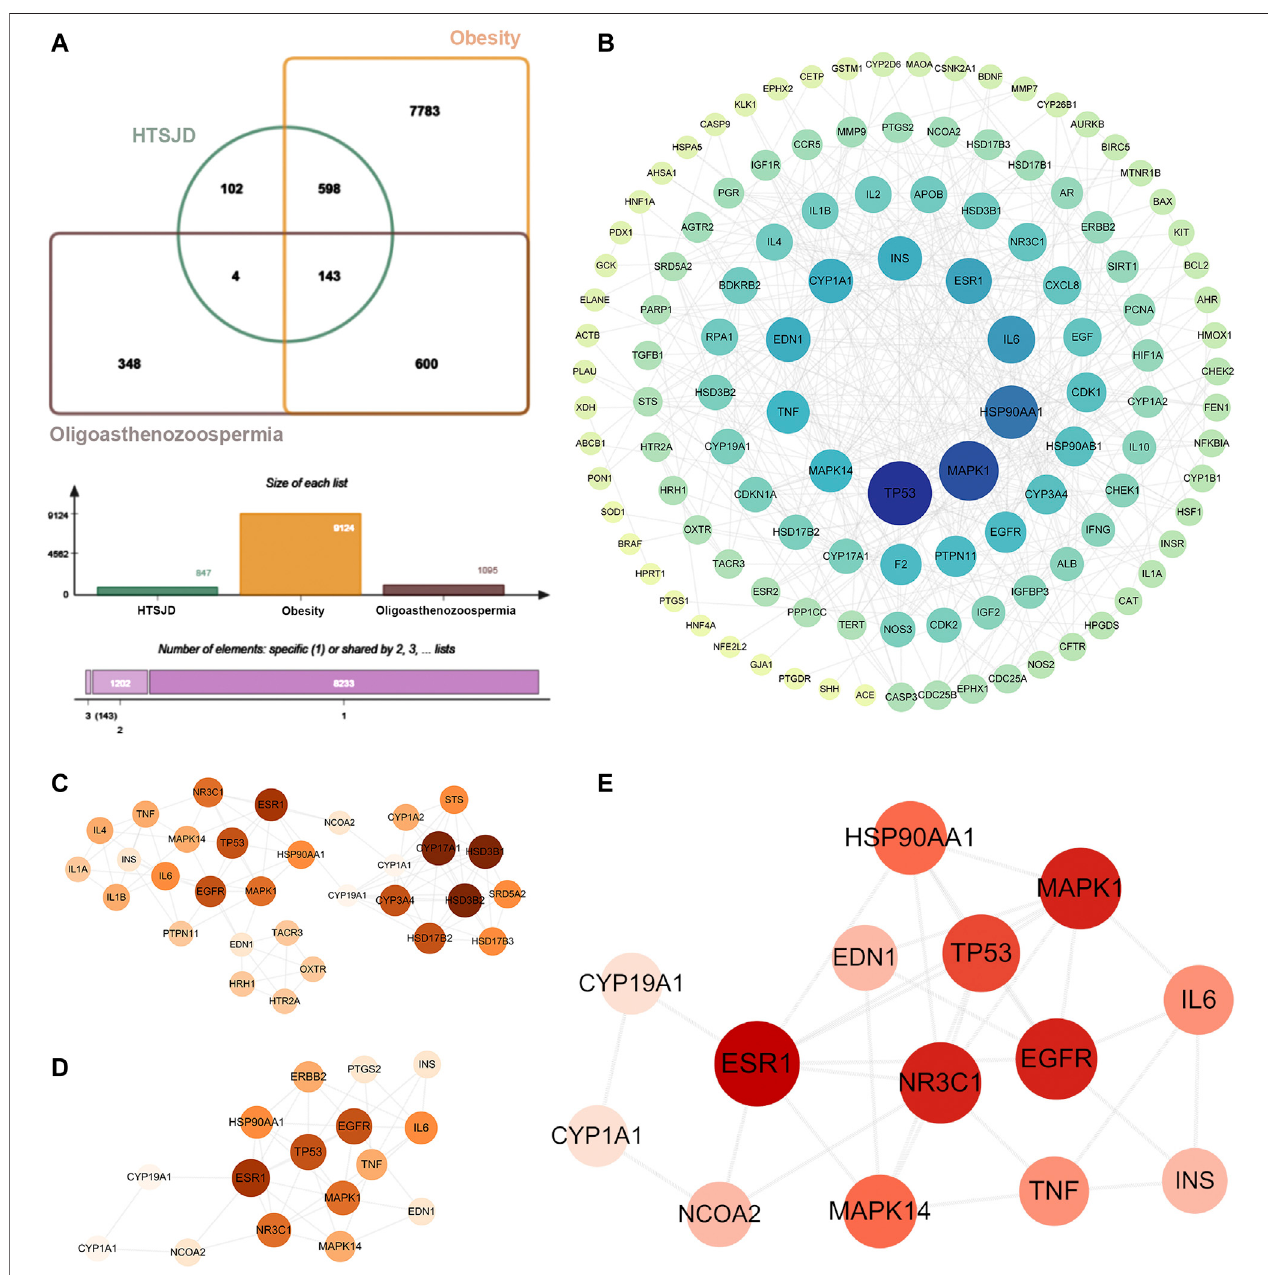
FIGURE4|(A) Venndiagramshowing143commonH-O-Otargets. (B) ThePPInetworkofH-O-O. (C) Genesidenti fi edbythecytohubba. (D) Genesidenti fi edby the cytoNCA. (E) Hub genes were determined after the intersection. The darker node color or larger font size implies larger degree